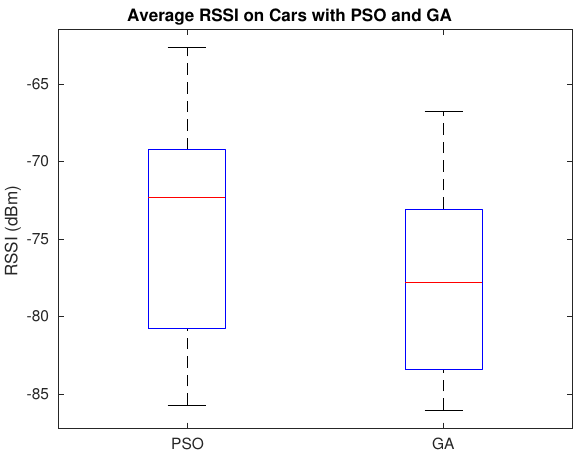
Figure 10. Average RSSI values at the receivers.